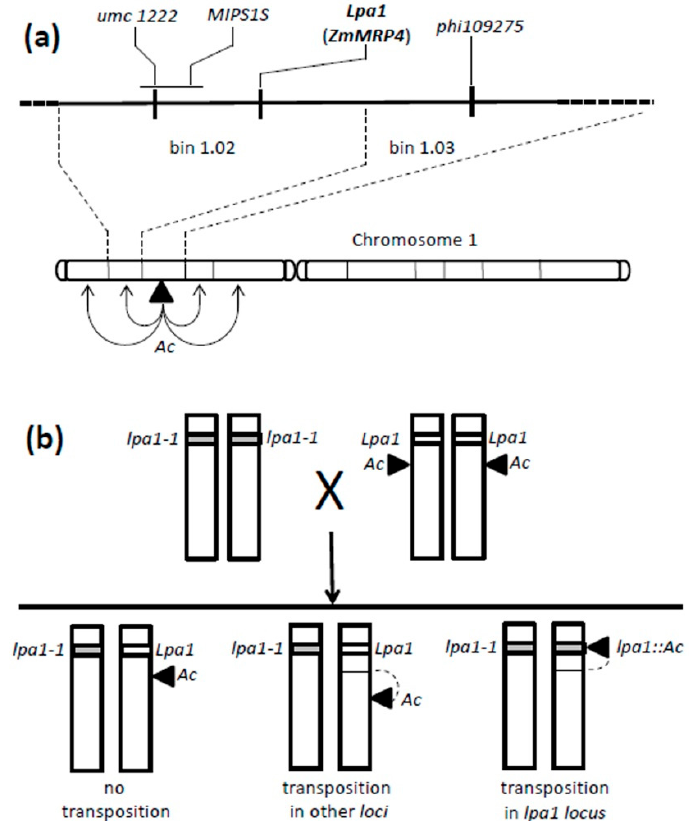
Figure 1. ( a ) Diagram of chromosome 1, the position of the Ac element and of ZmMRP locus, bin 1.02/1.03 are indicated. ( b ) Genetic scheme used to generate the F1 mutagenized